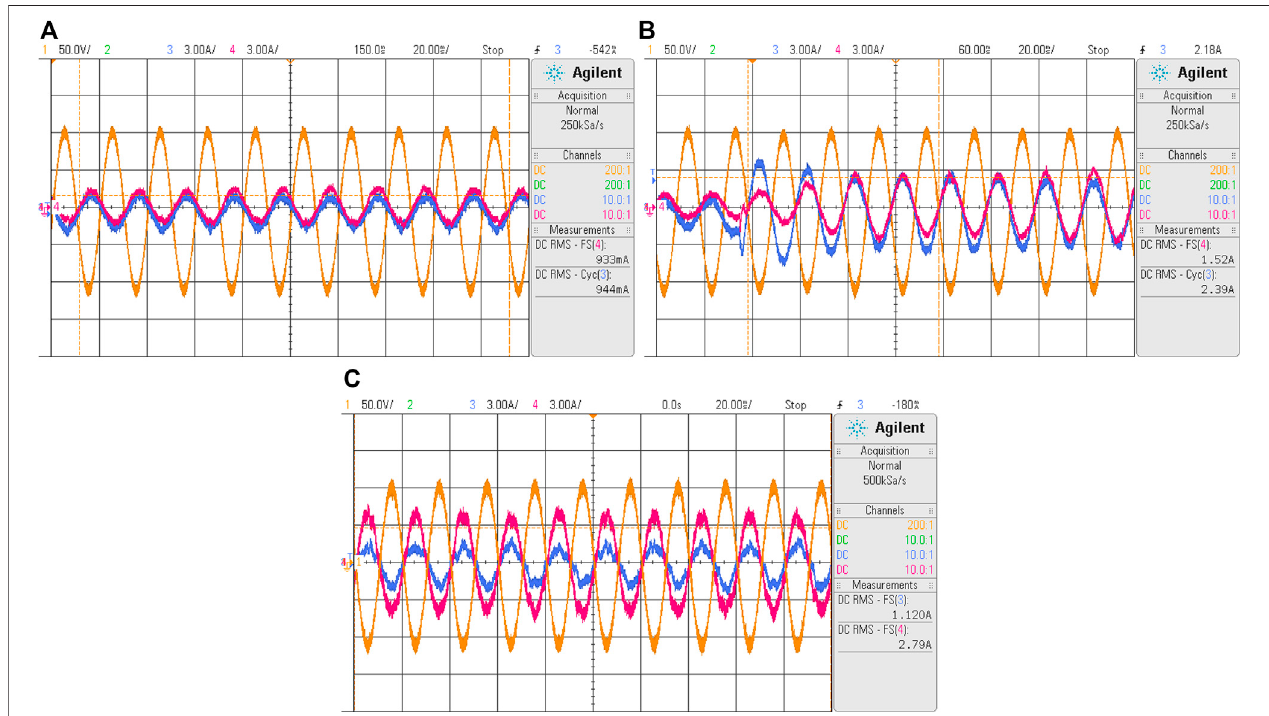
FIGURE11| Steady-statecondition.Line-neutralvoltageatreferencephase(yellow),referencephasecurrentofgrid-formingconverter(blue),andreferencephase current of grid-support converter (magenta). (A) initial steady state, (B) resistive load change with SoC 0 (cid:2) SoC 1 (cid:2) 0 . 5, and (C) steady state with resistive load with grid forming SoC 0 (cid:2) 0 . 45 and grid support SoC 1 (cid:2) 0 . 5.